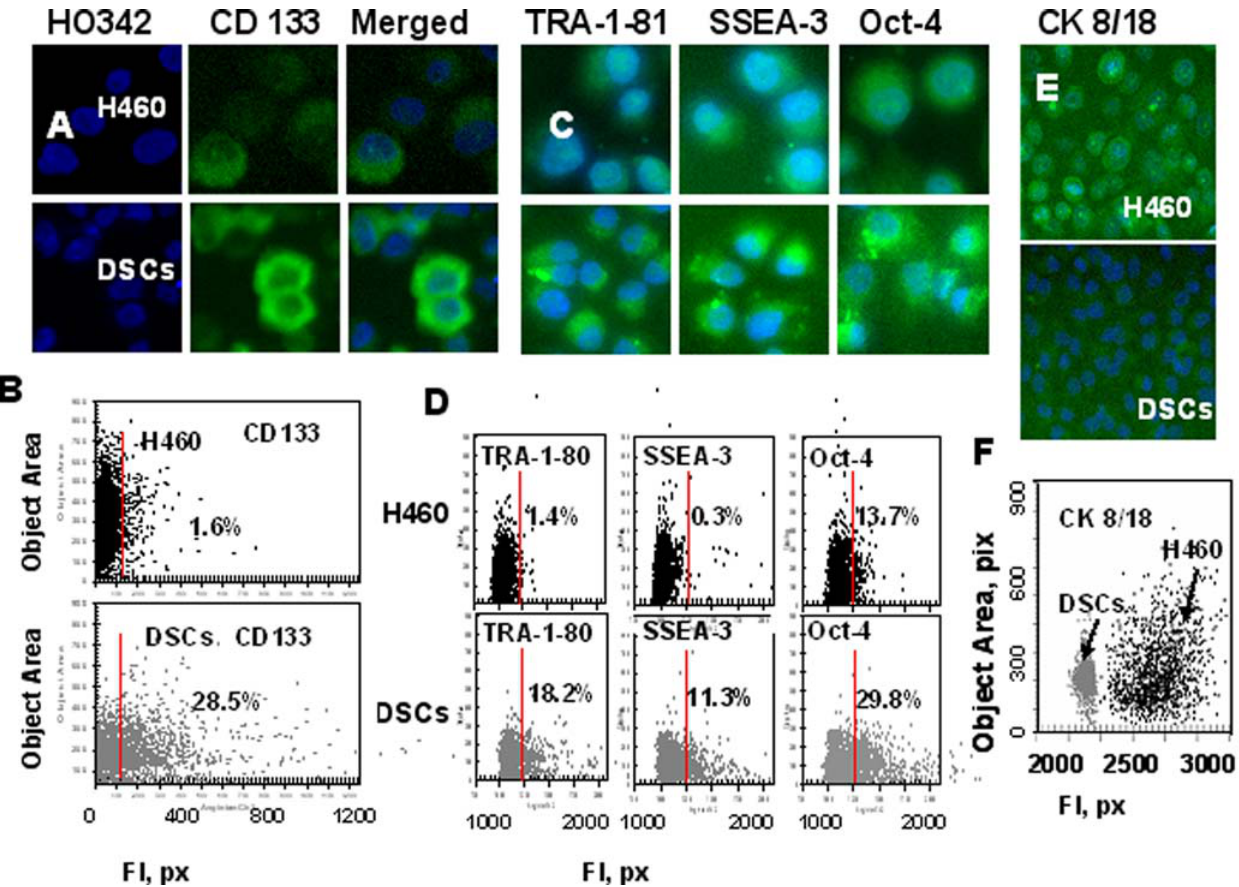
Figure 2. Analysis of CD133, embryonic stem cell (ESC) markers and cytokeratins 8/18 expression in H460 cells and DSCs. H460 cells and DSCs, growing in 96-well plates, were fixed and incubated with primary Abs against CD133, TRA-1-81, SSEA-3, Oct-4, or cytokeratins8/18 and then with secondary Abs. Cell nuclei were stained with Hoechst 33342. Cell images were acquired using the Cellomics ArrayScan HCS Reader (20X, 40X objectives) and analyzed using the Target Activation BioApplication Software Module. A, Immunofluorescent images of tumor cells. B, Fluorescence intensity (pix) of CD133 plotted against object area. Each point represents a single cell. Cells to the right of the red line are CD133 + (above IgG control staining). C, Images of tumor cells immunofluorescently stained tumor cells for TRA-1-81, SSEA-3 and Oct-4 ES cell markers. D. Fluorescence intensity of TRA-1-81, SSEA-3 and Oct-4, plotted against object area. Each point represents a single cell . Cells to the right of the red line are positive (above IgG control staining). E, Images of immunofluorescently stained tumor cells for cytokeratins8/18. F, Fluorescence intensity of cytokeratins8/18 in H460 cells (black dots) and DSCs (grey dots) plotted against object area .